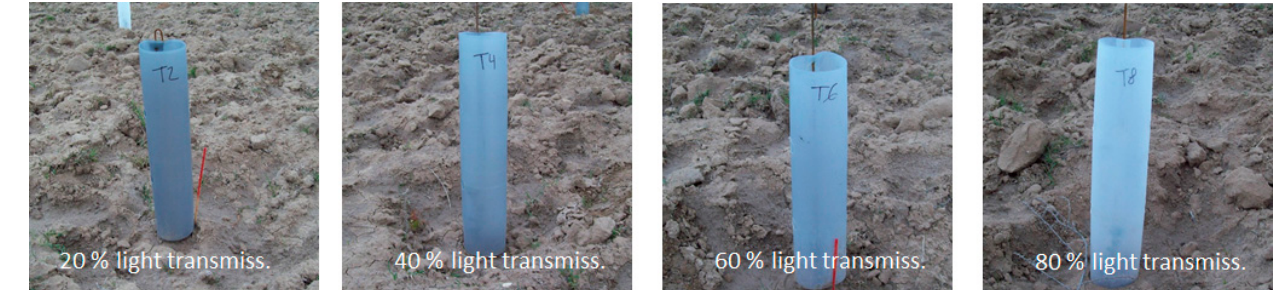
15 of 17 Table A1. Mean ± standard deviation of soil index from Alcázar and Alicante sites. Three composite soil samples were collected from establishment sites. Alcázar